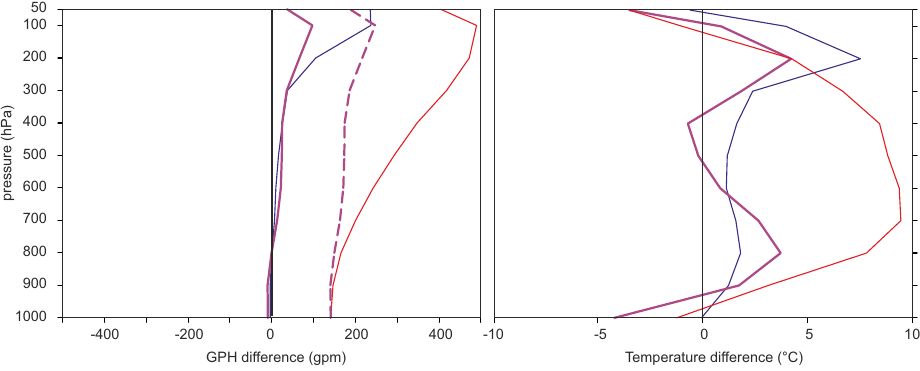
Fig. 5. Vertical profile of the difference between observations from the MS Schwabenland and 20CR for GPH (left) and temperature (right). Red = uncorrected profiles for the ascents #50–61, blue=all other ascents, thick purple=corrected profiles of ascents #50–61 (dashed: no altitude offset at 1000hPa). Note that the 1000hPa level was below sea level during ascents #50–61 and hence these values were extrapolated on the original data